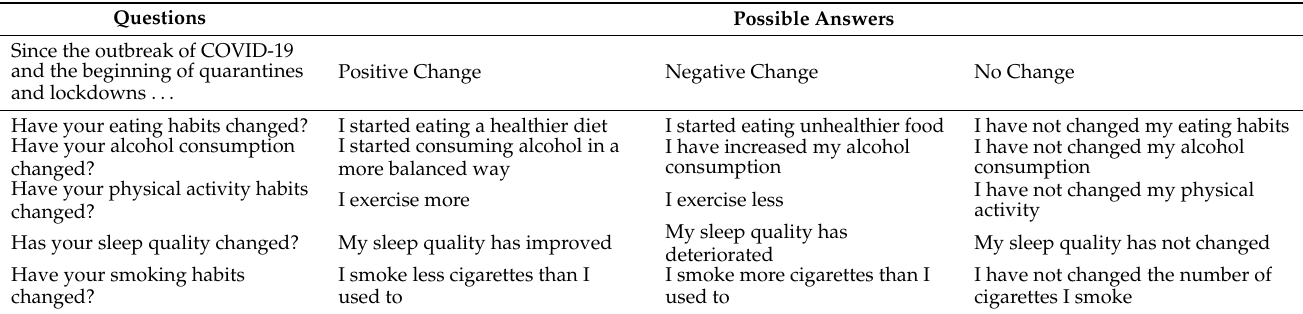
Table 2. Questions and possible answers regarding the nature of